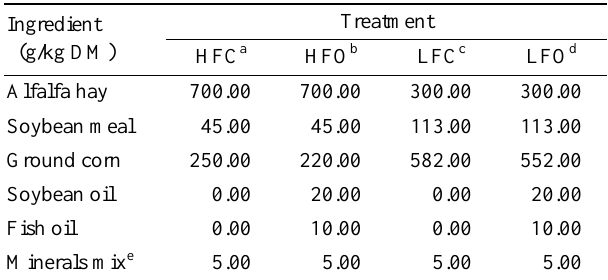
Table 1. Ingredients of treatment